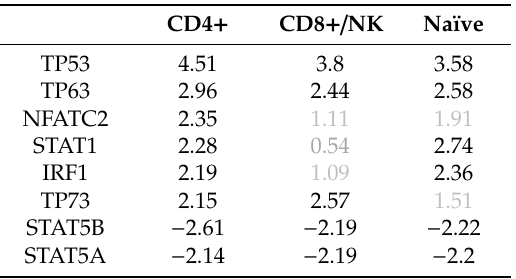
Table 4. Z -value of the upstream regulators identified in each of the three clusters generated by Ingenuity Pathway Analysis (IPA). Significantly regulated genes were defined by fold > 2.0 and p < 0.001. STAT1 and IRF1 had a Z value below 2 in only the CD8 +/ NK cells.